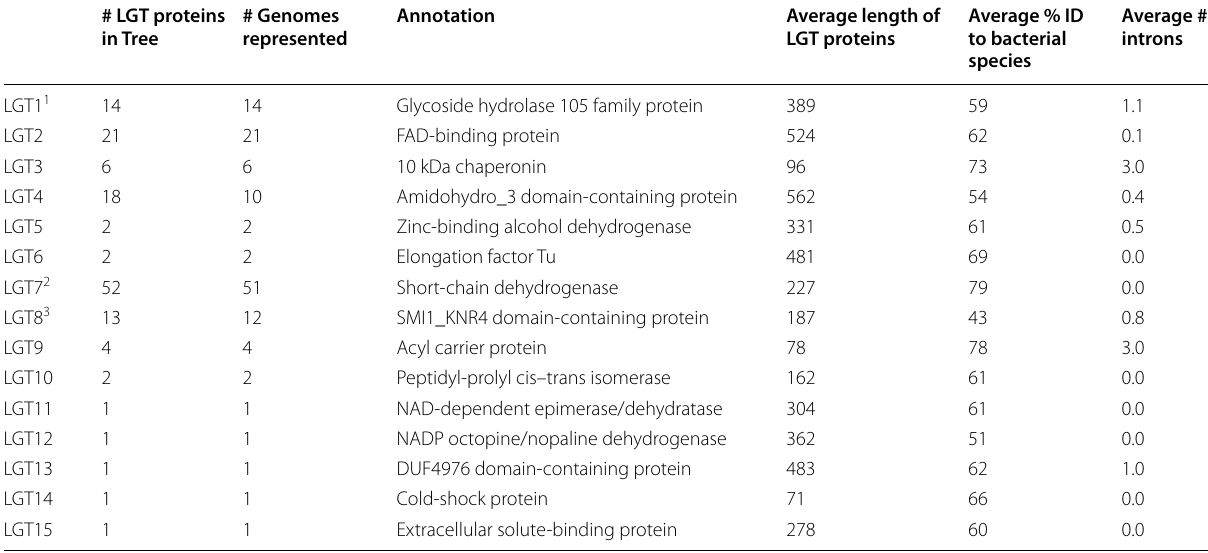
1,2,3 correspond to HGT56, HGT1, and HGT18 previously located by Wang and Ruan et al. (Wang and Ruan